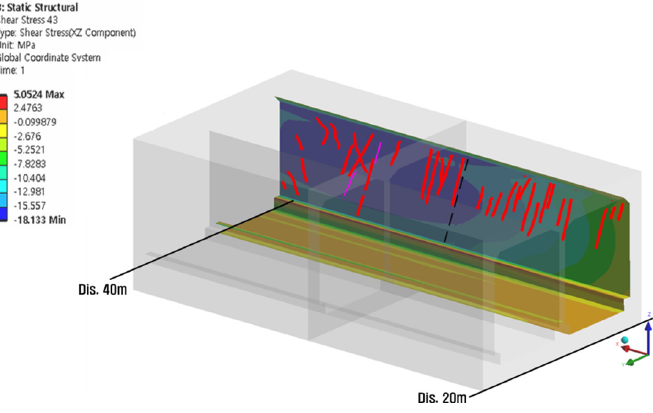
Figure 12. Comparison between the visual inspection mesh diagram and analysis results (Cell 2 wall) for heaving section.